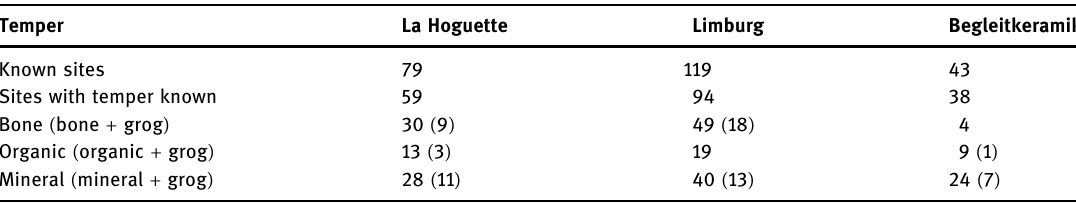
Table 2: Sites with Non - LBK pottery, categorized according to temper Temper La Hoguette Limburg Begleitkeramik Known sites 79 119 43 Sites with temper known 59 94 38 Bone ( bone + grog ) 30 ( 9 ) 49 ( 18 ) 4 Organic ( organic + grog ) 13 ( 3 ) 9 ( 1 ) Mineral ( mineral + grog ) 28 ( 11